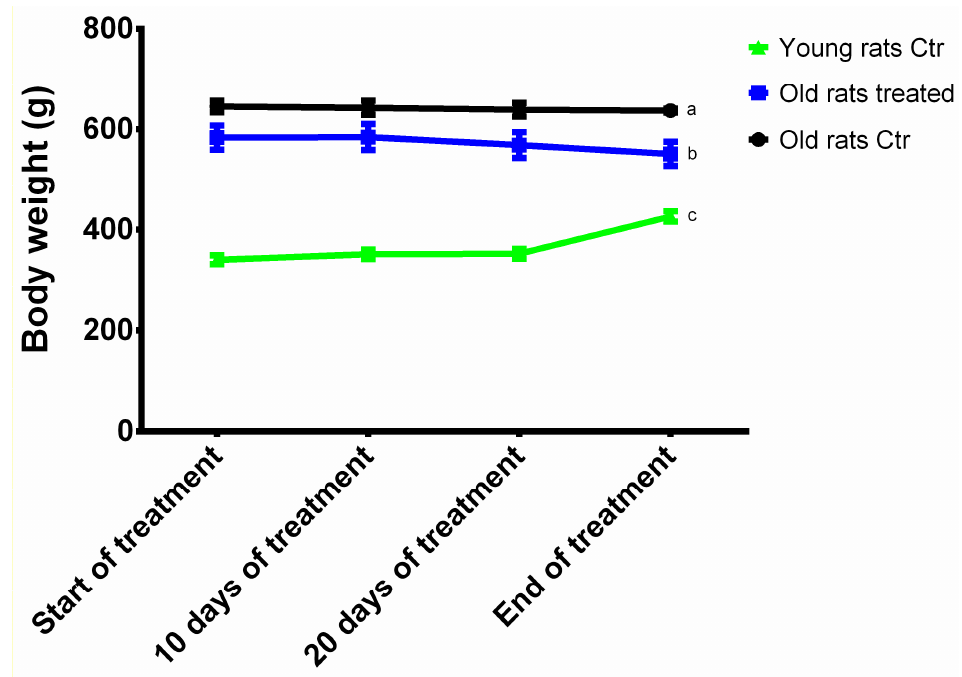
Figure 1. Body weight variations. Results are expressed as mean ± SEM, and p < 0.05 was considered statistically significant. Statistical significance was calculated by one-way ANOVA followed by Bonferroni’s post-hoc test. Di ff erent letters reveal significant di ff erences. Old rats Ctr refers to old animals treated with placebo; Old rats treated refers to old animals treated with Taurisolo ® ; Young rats Ctr refers to young animals treated with placebo. T0 refers to the beginning of the treatment and t30 refers to the end of the treatment.